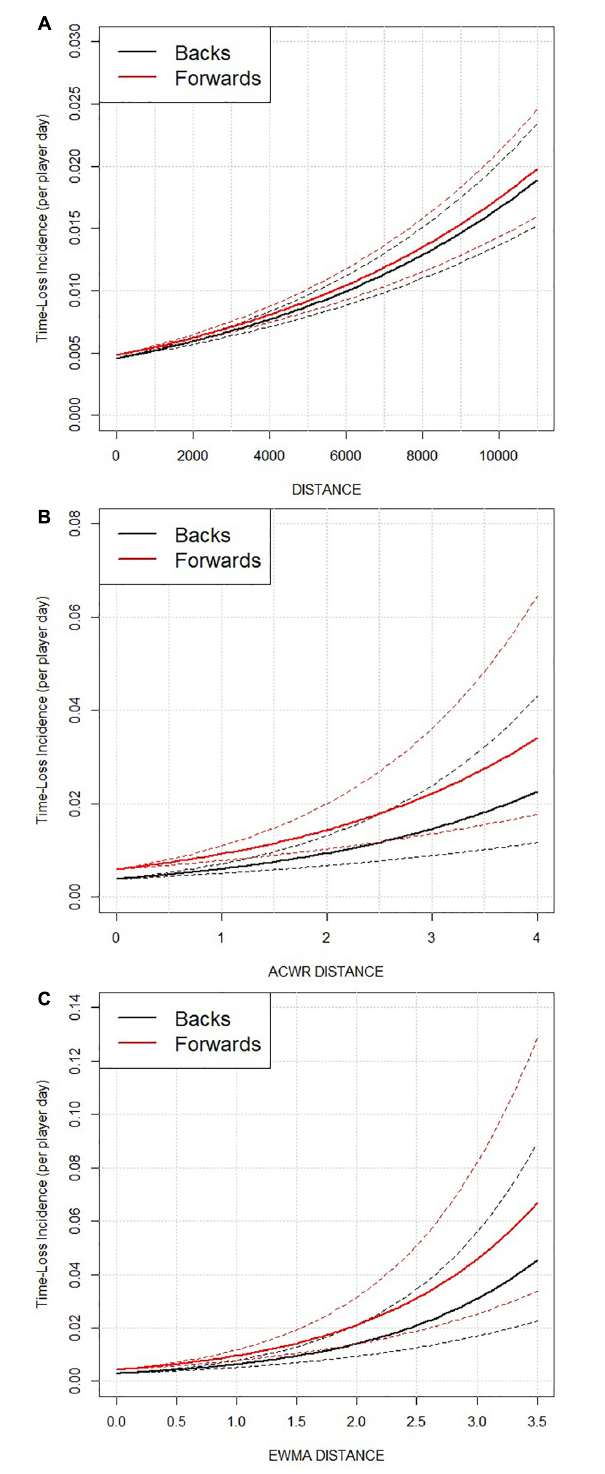
FIGURE 2 | The relationship between time-loss incidence occurrence (per player day) and absolute distance ( p < 0.001) (A) , ACWR distance ( p = 0.008) (B) , and EWMA distance ( p < 0.001) (C) , split for backs and forwards. Data are mean ± standard error.